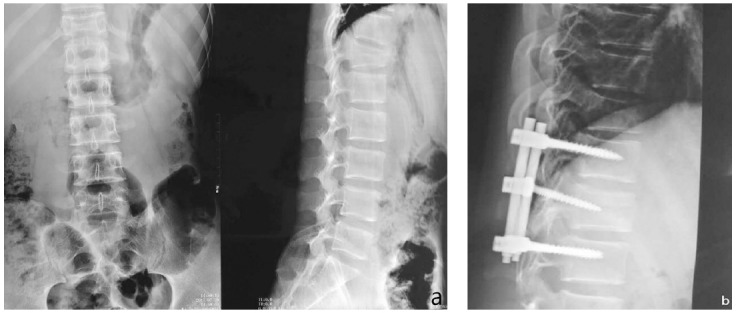
Male, aged 57 years old, a: T-12 vertebral compression fracture before surgery (III degree); b: screw-rod internal fixation after surgery and and no graft for the diseased vertebra.